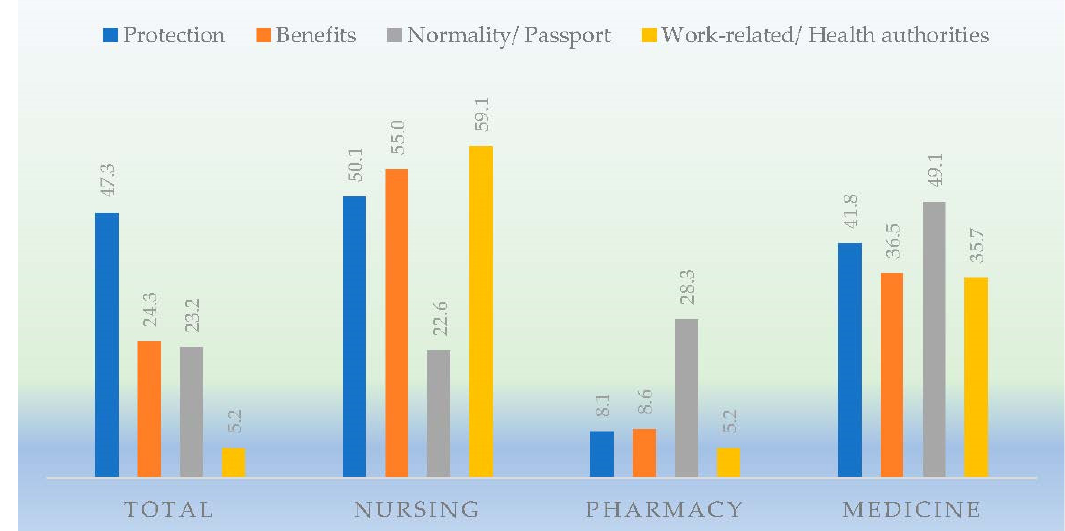
Figure 1. Reasons for the acceptance towards the vaccines against the COVID-19 disease in students of the three degrees.